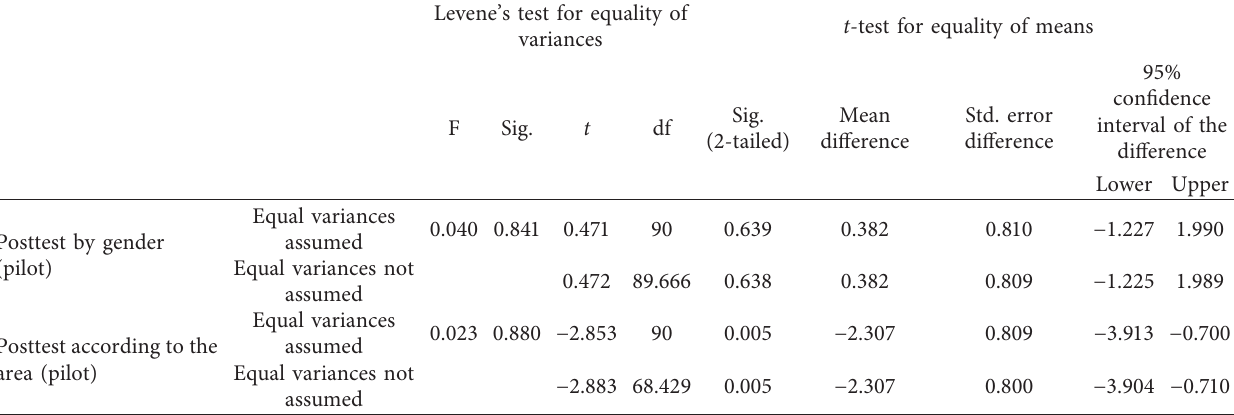
Table 9: The t -test of independent samples (posttest) according to the method, gender (pilot), and the area (pilot). Levene’s test for equality of